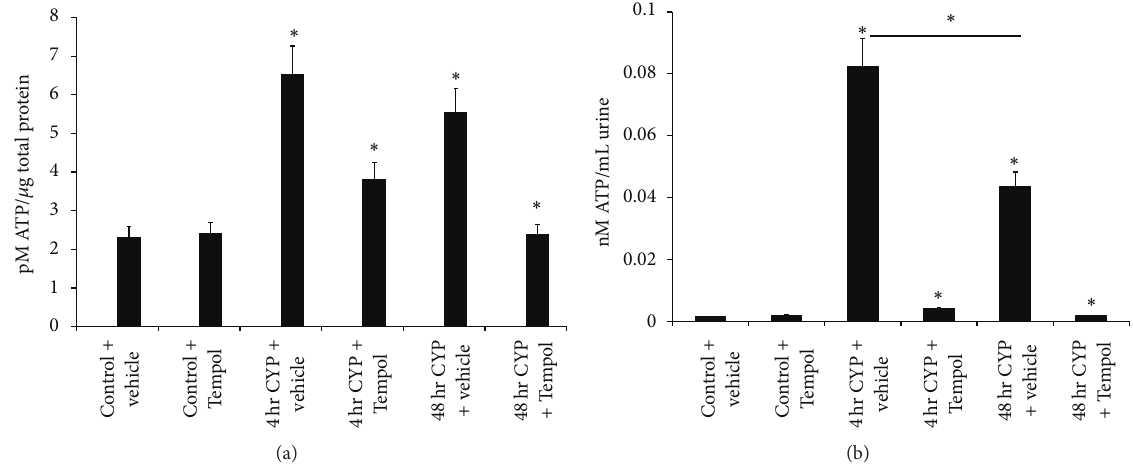
Figure 4: Cyclophosphamide- (CYP-) induced cystitis increases adenosine triphosphate (ATP) in the urinary bladder and cystometric fluid and the antioxidant, Tempol, reduces expression. (a) 4hr and 48 hr CYP-induced cystitis significantly ( 𝑃 ≤ 0.01 ) increased ATP expression in urinary bladder that was significantly ( 𝑃 ≤ 0.01 ) reduced with Tempol. Tempol was without effect on ATP expression in urinary bladder from control (no CYP) rats. (b) 4 hr and 48 hr CYP-induced cystitis significantly ( 𝑃 ≤ 0.01 ) increased ATP expression in cystometric fluid that was significantly ( 𝑃 ≤ 0.01 ) reduced with Tempol. Tempol was without effect on ATP expression in cystometric fluid from control (no CYP) rats. ∗ 𝑃 ≤ 0.01 . 𝑛 = 6 for control and treatment